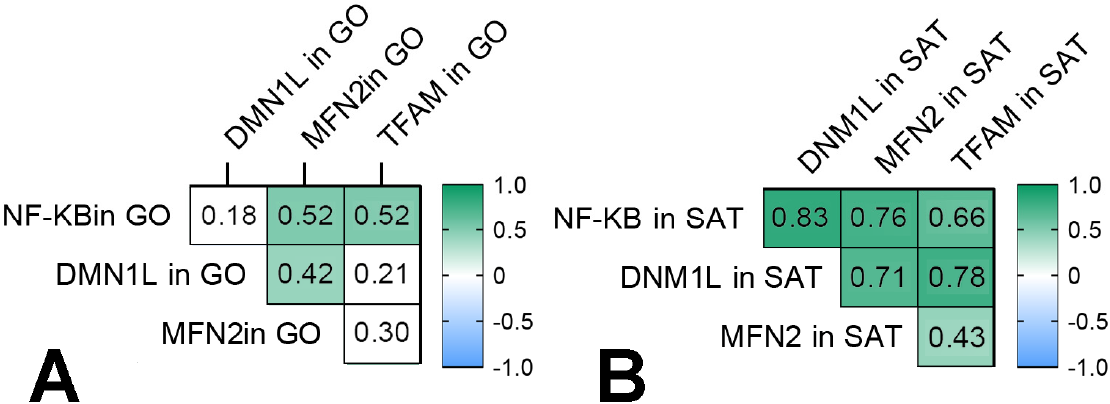
Figure 9. Correlation relationships of NF-kB1, DNM1L, MFN2, and TFAM gene expression in GO and SAT. Filled squares show significance ( p < 0.05). ( A ) correlation relationships in GO; ( B ) correlation relationships in SAT.